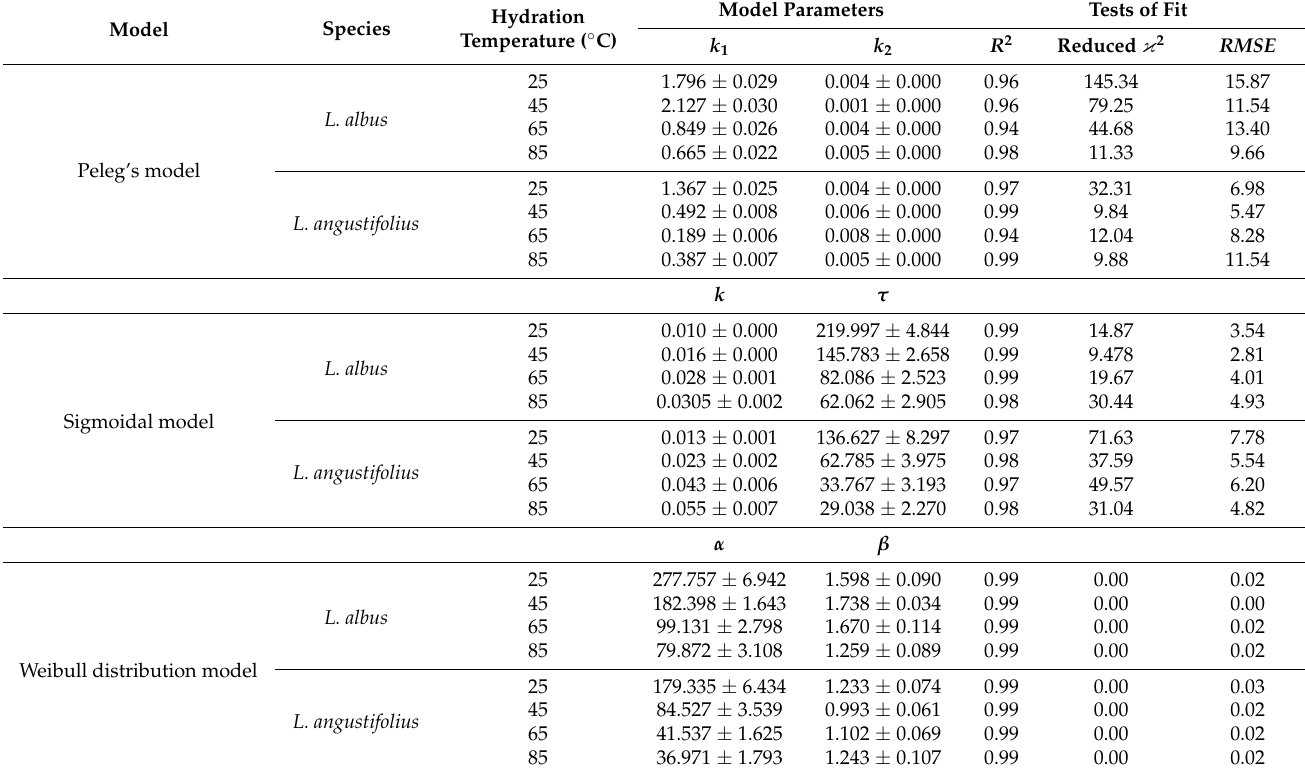
Table 3. Complied model